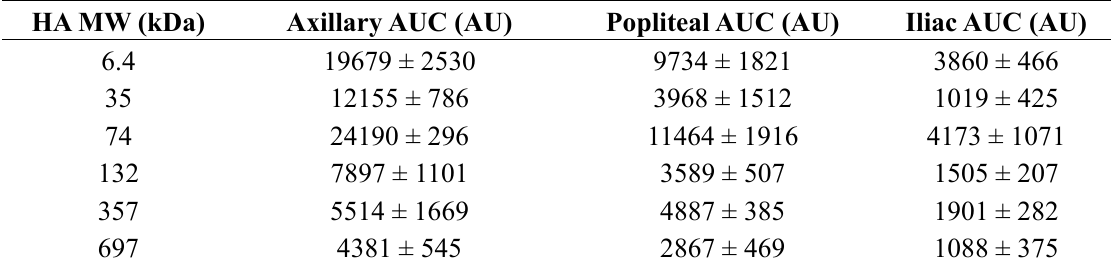
Table 5. The AUCs of the lymphatic drainage kinetics of different MW HA-IR820 conjugates after s.c. administration into the axillary, popliteal and iliac lymph nodes of BALB/c